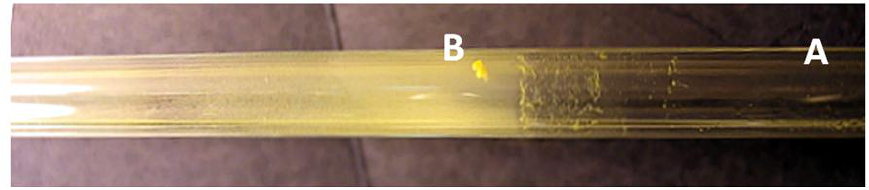
Figure 18. Photograph of a glass tube, used for cold trapping of TNT molecules from the gas phase. The right side (A) of the glass tube was close to room temperature, while the left side (B) was immersed in liquid nitrogen during purging with 1000 L of N TNT molecules.